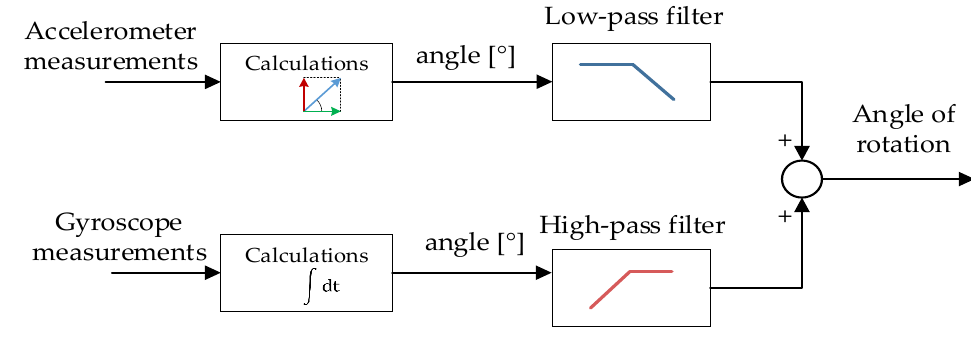
Figure 2. Complementary filter block schematic.